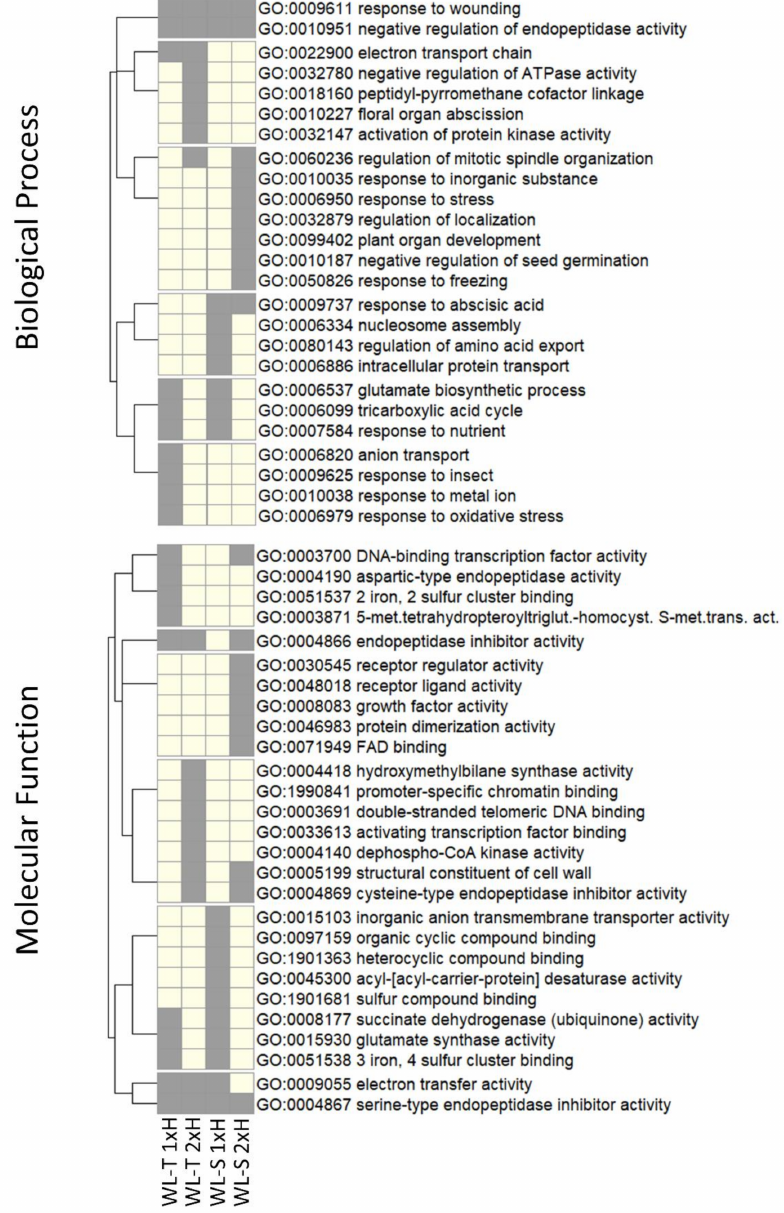
Figure 5. The top enriched GO categories in the Biological Process (BP) and Molecular Function (MF) determined for DE-lncRNAs target genes in non-primed (1xH) and primed (2xH) plants in two cucumber accessions, i.e., WL-T and WL-S under long-term waterlogging. Grey colour means presence of the term, whereas white colour indicates lack of statistically significant enrichment for the